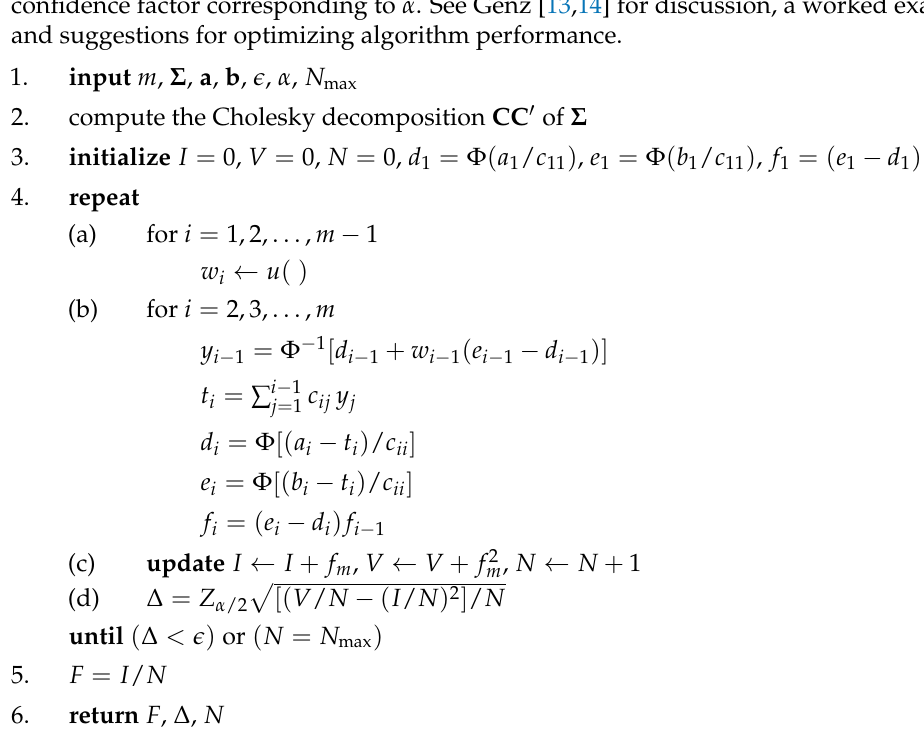
Algorithm 2 Genz Monte Carlo Estimation of the MVN Distribution